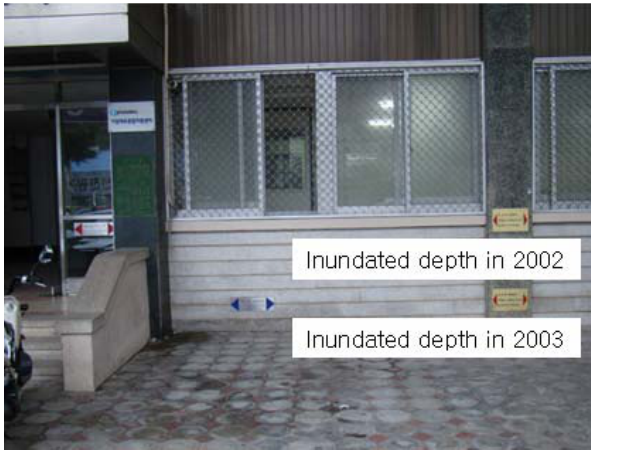
Fig. 5. Discharge hydrograph at bank break point (rainfall data : WAter Management Information System, http://www.wamis.go.kr/)